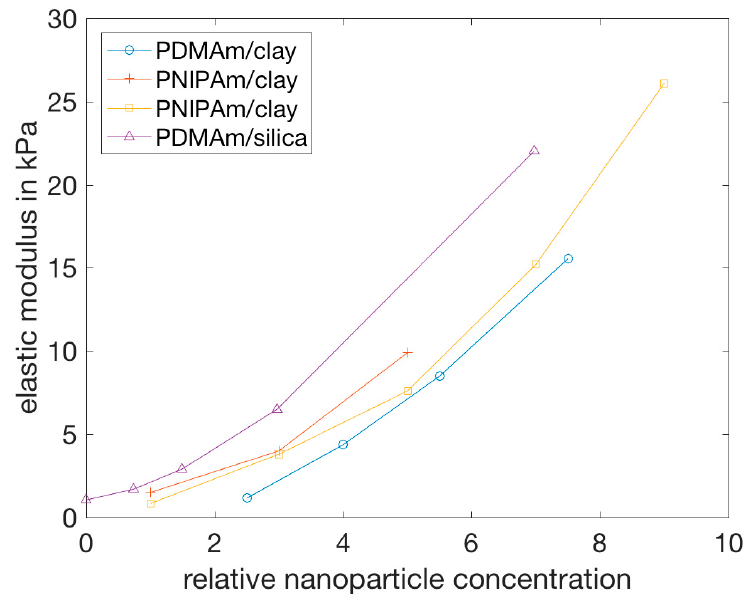
Figure 5. Elastic moduli for different nanocomposite hydrogels. Replotted using data from PDMAm/clay [109] (blue dots), PNIPAm/clay [17,59] (yellow squares and red crosses), and PDMAm/silica [52] (purple triangles). The concentration of clay particles is C Clay = ( 100 ) , with m Clay representing the weight of clay per 1000 mL of water and M clay representing the molecular mass of clay [17,59,109]. The silica NP concentration is the weight ratio between silica and DMA [52]. The amount of polymer in the samples varied from approximately 1.5 g to 6 g.